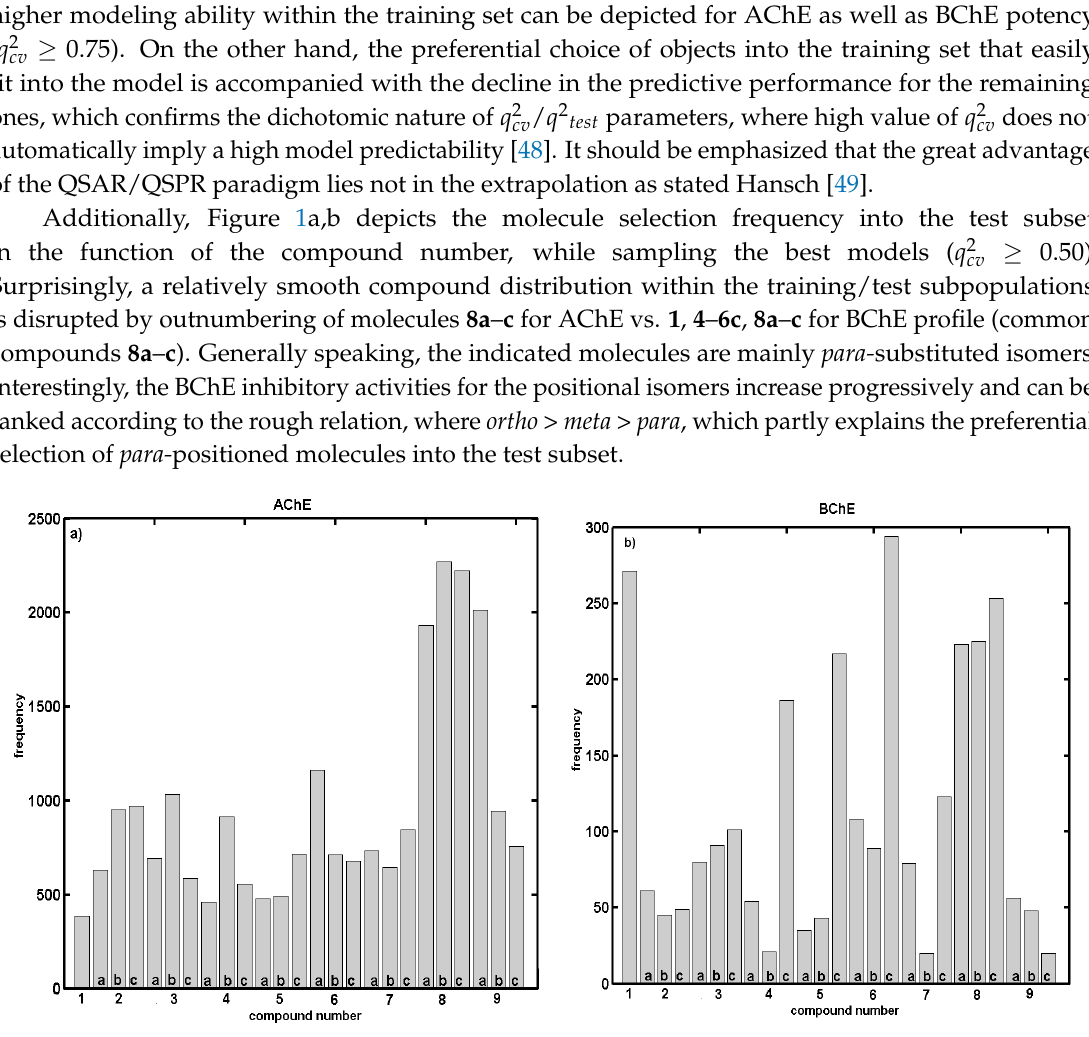
Figure 1. Histograms specify number of individual compounds appearing in test set within regions of q 2 cv > 0.5 for training set against q 2 L–7–O CV for modeling: AChE ( a ); and BChE ( b ) potency of proline-based carbamates derivatives with CoMSA method.